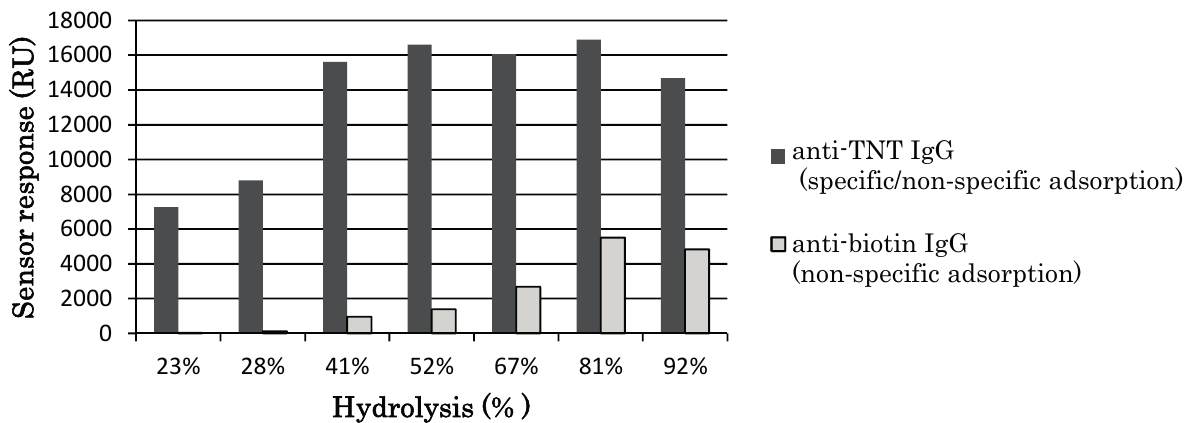
Figure 5. Hydrolysis dependence of specific/non-specific adsorption